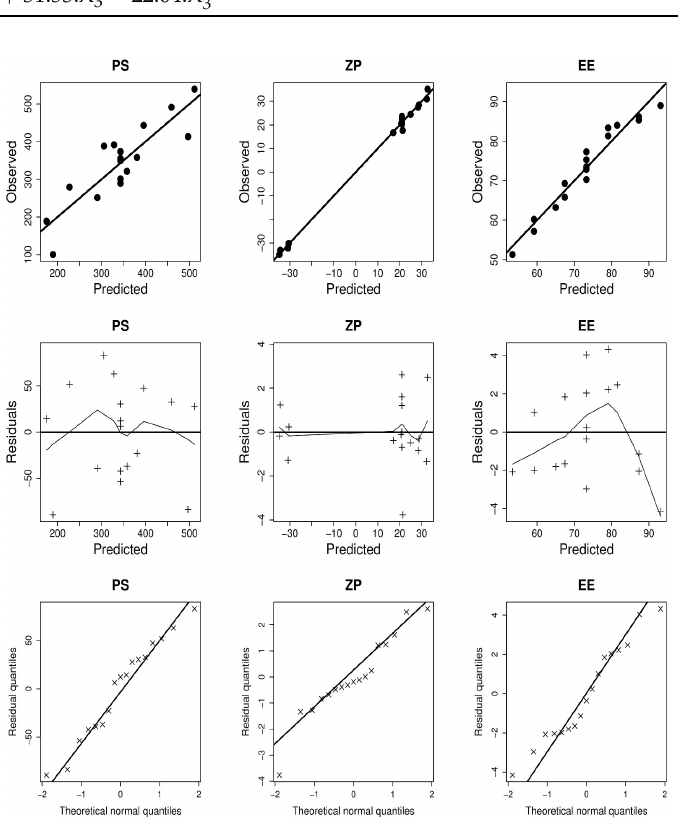
Figure 1. The diagnostic graphs of the response variables